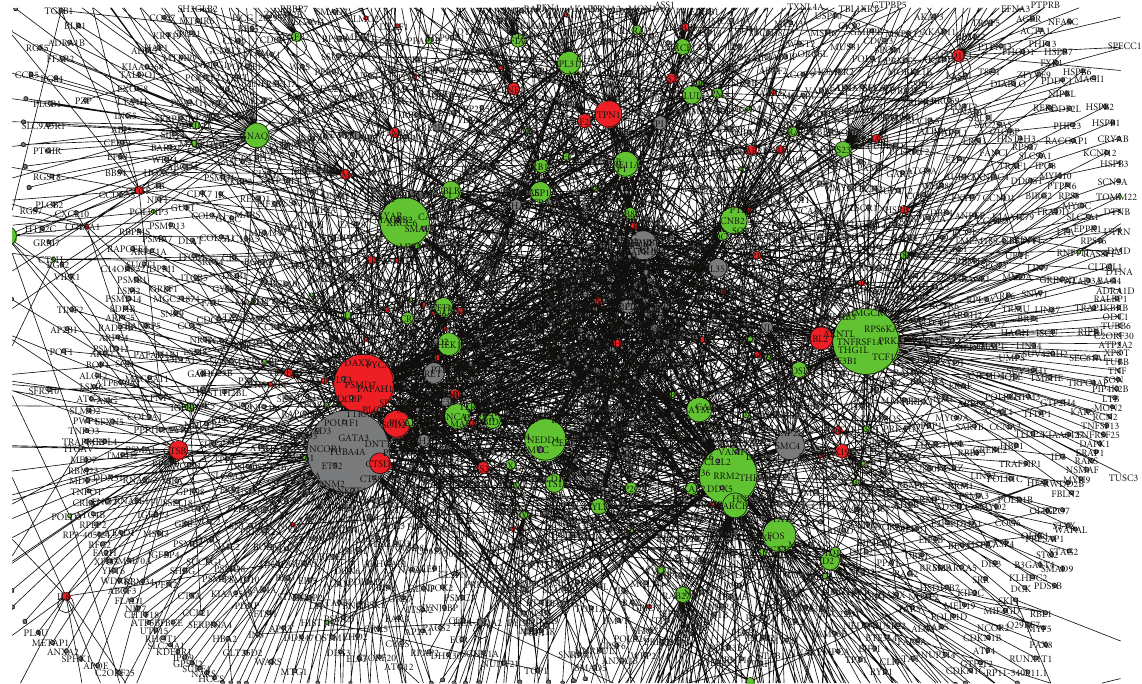
Figure 1: A view of protein to protein interaction associated with the di ff erentially expressed genes. We refer to this graph as